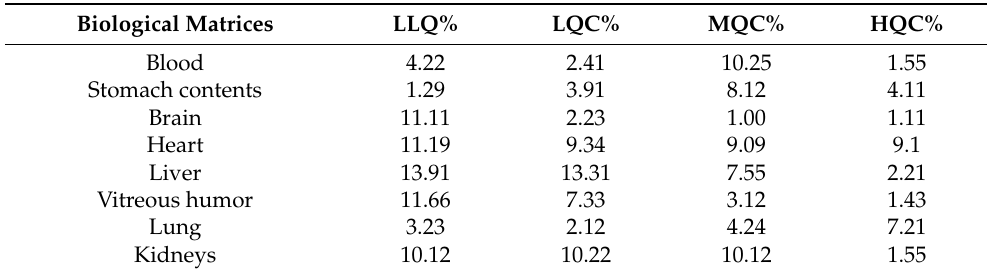
Table 10. Lower limit of quantification (LLQ), low-quality control (LQC), medium-quality control (MQC), and high-quality control (HQC) calculated in each matrix, in triplicate, intracutaneous and intercurrent to